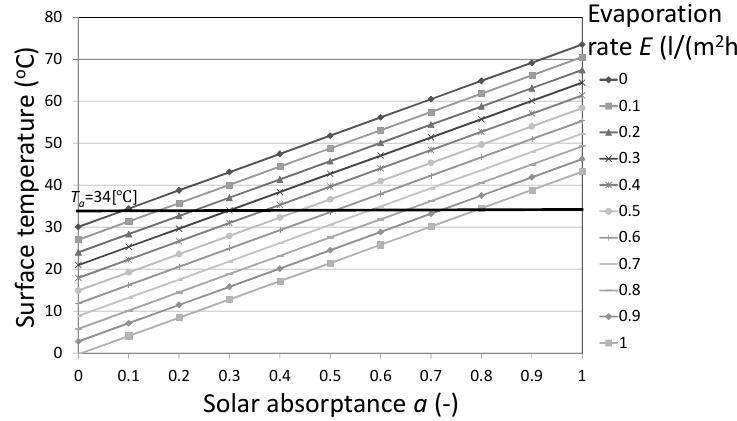
Figure 8. Relationship between the surface temperature T s of the adaptation measures and the solar absorptance a when the heat transfer coefficient h is 23 W/(m 2 K), emissivity ε is 0.97, and net infrared radiation q is −93 W/m 2 for different values of the evaporation rate E .